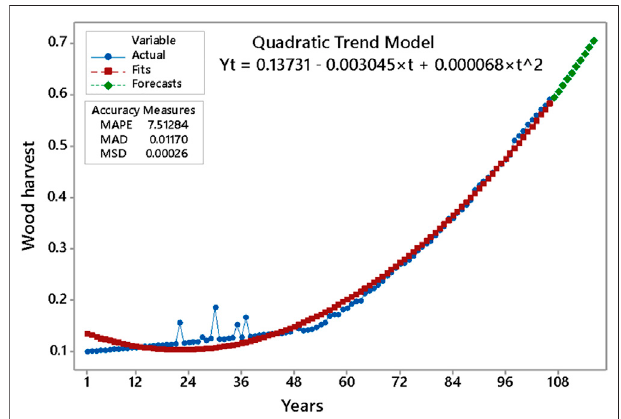
FIGURE 3 | Year wise trend in wood harvest (million m 3 ).